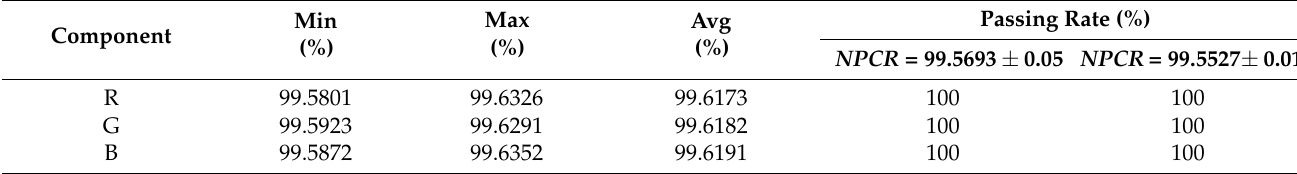
Table 6. Statistical results of NPCR in Table 5.